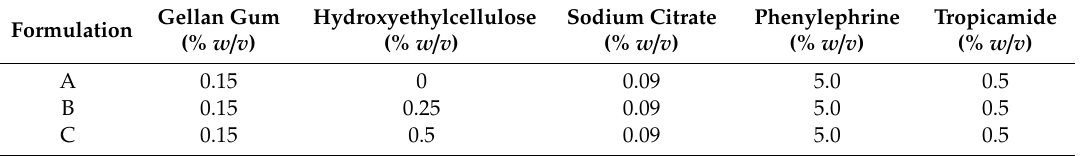
Table 1. Composition of the in situ gelling delivery